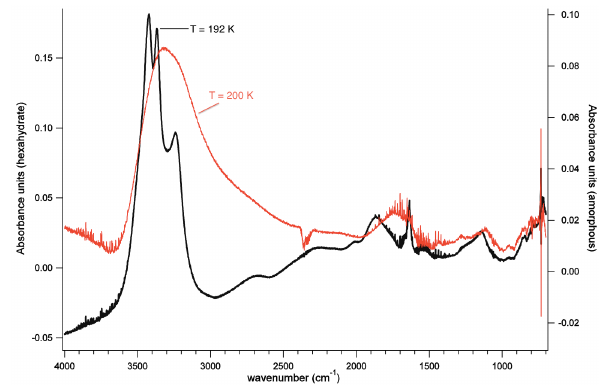
q Fig. 10. IR spectrum of an initial HCl 6H 2 O film generated at 170K using a dose leading to 8 × 10 16 molecules of adsorbed HCl. Figure 10. IR spectrum of an initial HCl•6H 2 O film generated at 170 K using a dose leading to 8 x The HH film was heated to 192K (black trace) and subsequently 10 16 molecules of adsorbed HCl. The HH film was heated to 192 K (black trace) and subsequently to 200 K (red trace). This experiment was performed under static conditions. to 200K (red trace). This experiment was performed under static